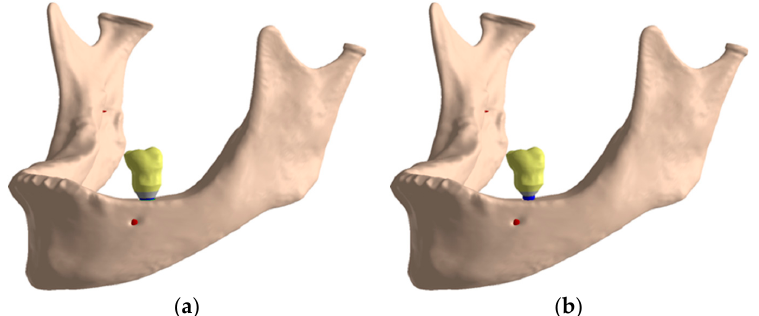
Figure 4. Final assembly: ( a ) IH connection; ( b ) MT connection.